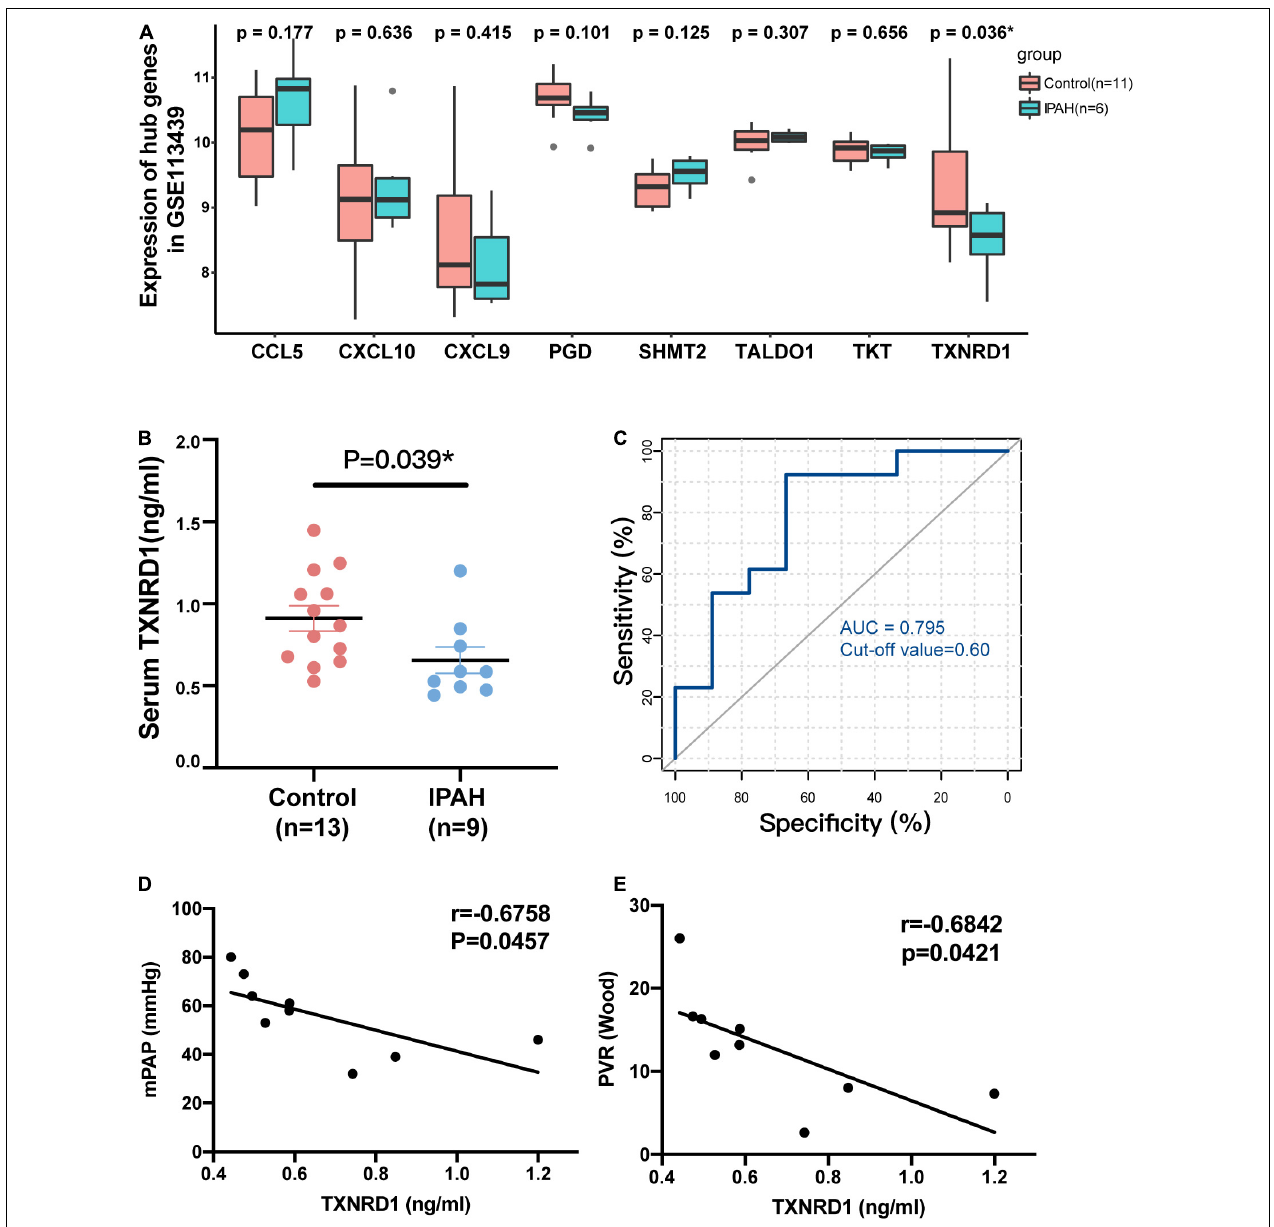
FIGURE 5 | Validation of TXNRD1 in clinical samples. (A) Gene expression of hub genes in GSE113439. (B) Serum TXNRD1 was decreased in IPAH patients. (C) The ability of serum TXNRD1 levels to diagnose IPAH was assessed using ROC curve analysis. (D,E) The relationship between serum TXNRD1 and mPAP as well as PVR analyzed by Spearman’s correlation